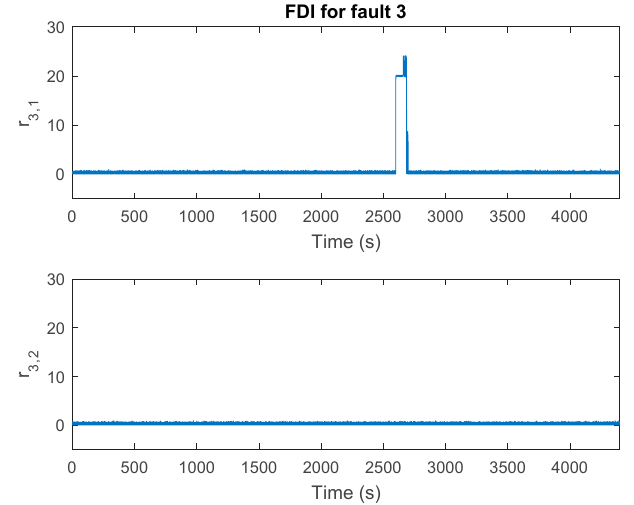
Figure 7. Fault bias in the third pitch during the time 2600 to 2700 s.